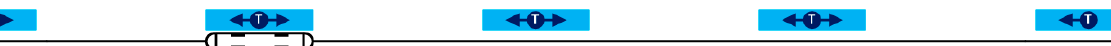
Figure 8. Using the bi-directional tram to serve a single-track tram route on a shuttle basis.